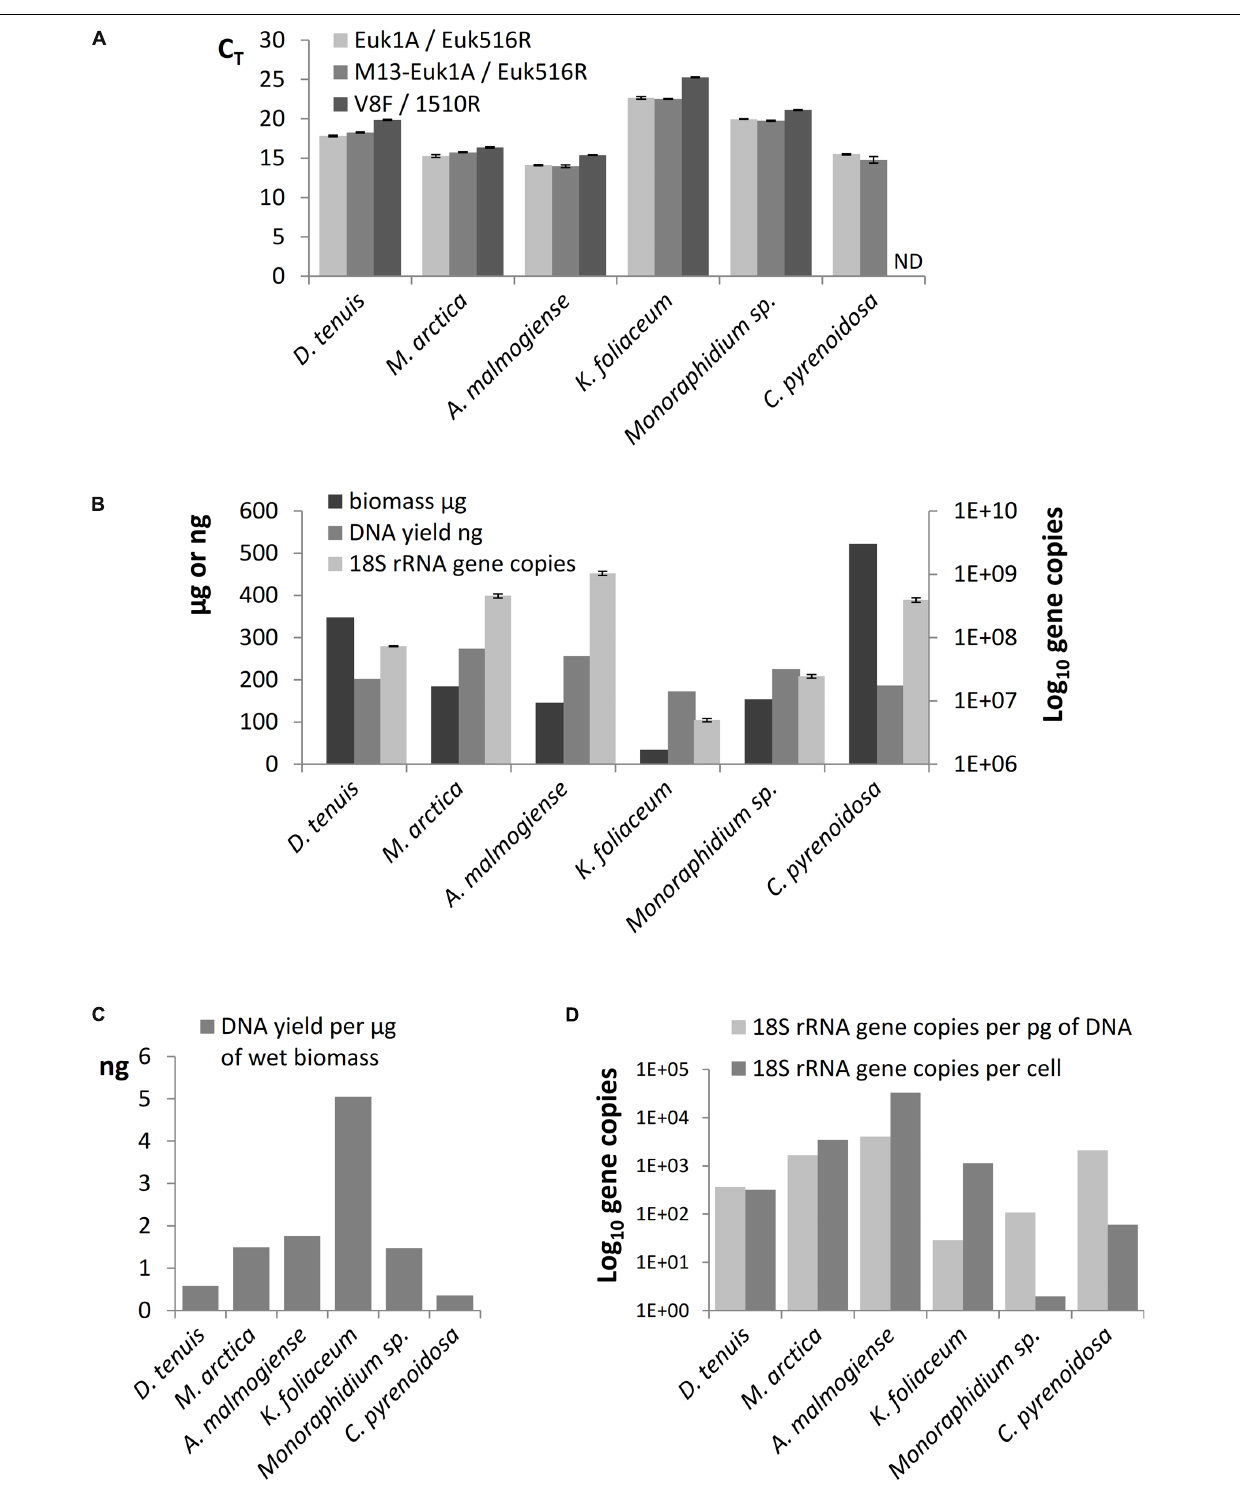
FIGURE 3 | (A) Comparison of threshold cycles (C T ) of qPCR when amplification of 18S rRNA genes was performed using Euk1A/Euk516R, M13-Euk1A / Euk516R and V8F / 1510r primer pairs from equal quantity of genomic DNA (4 ng). (B) Total wet biomasses, DNA yields, and 18S rRNA gene copy numbers per Power Biofilm extraction. qPCR results are presented as mean values of triplicates with standard errors. ND indicates the sample that was not possible to amplify with the V8F/1510R primer pair. (C) DNA yields per ng of wet biomass. (D) 18S rRNA gene copy numbers per cell and per pg of extracted DNA.